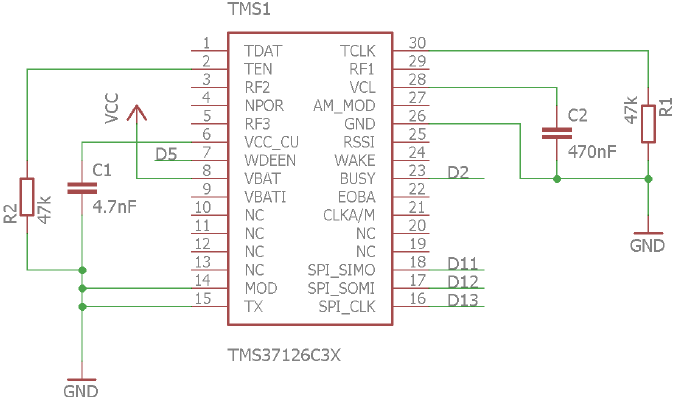
Figure 8: The correct pinout for the TMS37126 ICs we tested and an example schematic of how to connect it to an Arduino Pro Mini.